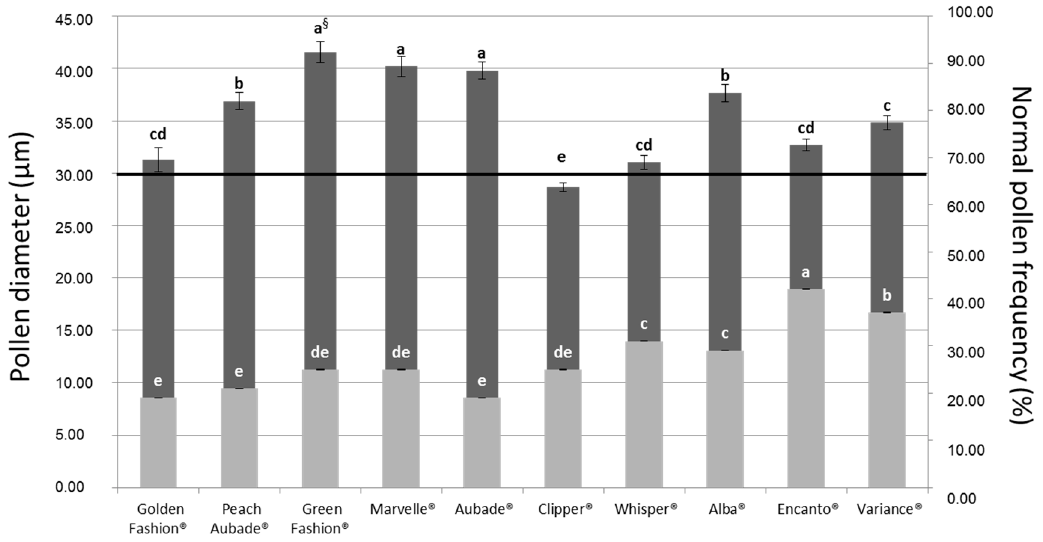
Figure 3. The pollen diameter ( μ m) (dark grey histograms) and the frequency of normal pollen (%) (light grey histograms) of the 10 studied rose cultivars. The black line at 30 μ m represents a threshold between low fertile pollen (<30 μ m) and high fertile pollen (>30 μ m) [4]. § Letters indicate the significance of differences between genotypes as determined by one-way ANOVA and Ryan-Einot-Gabriel-Welsch’s multiple stepdown F (REGW-F) post-hoc tests. Vertical bars indicate ± standard error.